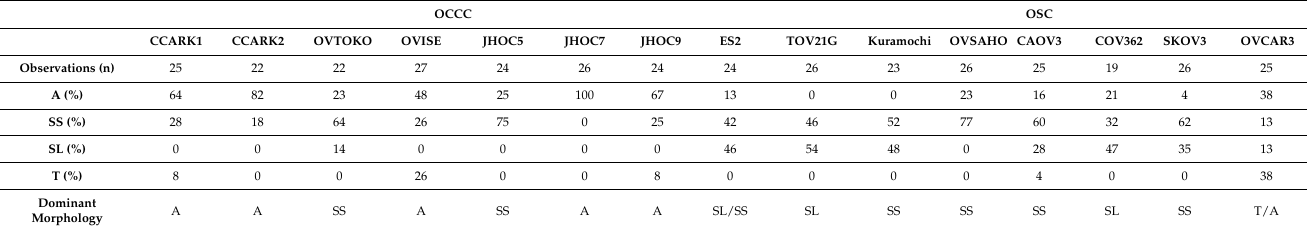
Figure 1. ( a ) Ovarian cancer cell lines demonstrated four distinct McTN phenotypes: absent, tufted, symmetric-long, symmetric-short. Representative images are shown. Scale shown with marker representing 6 µ m ( b ). As many as 30% of ovarian serous (OSC) (white bars) and clear cell (OCCC) (grey bars) cancer cells exhibited McTNs (n = 10). Mean and standard error of the mean are shown. ( c ) Freshly procured non-adherent OSC cells isolated from ascites also formed McTNs, which were observed through at least two passages. ( left to right ): unstained, Epcam (green), CellMask mem- brane stain (magenta), and overlay. Representative cells from OV47 with McTNs from passages 0 (left) and 2 (right). Table 1. Morphologies observed across ovarian clear cell (OCCC) (grey bars) and serous (OSC) (white bars) cell lines.